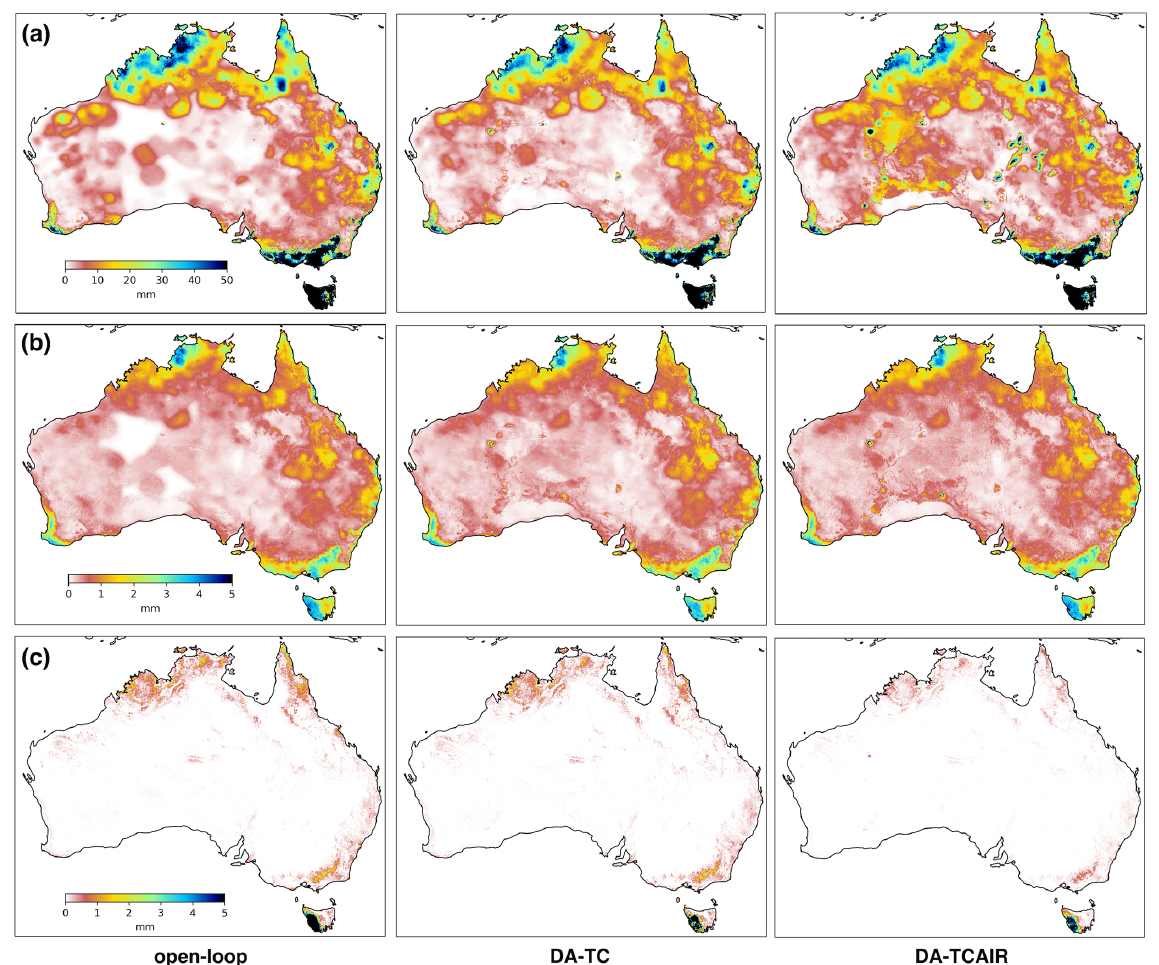
Figure 6. Averaged estimates of (a) shallow-layer (10–100cm) soil water storage ( S s ), (b) evapotranspiration ( E tot ) and (c) total stream- flow ( Q tot ) for December 2019 from model open loop, data assimilation (DA-TC) and after the analysis increment redistribution (DA-